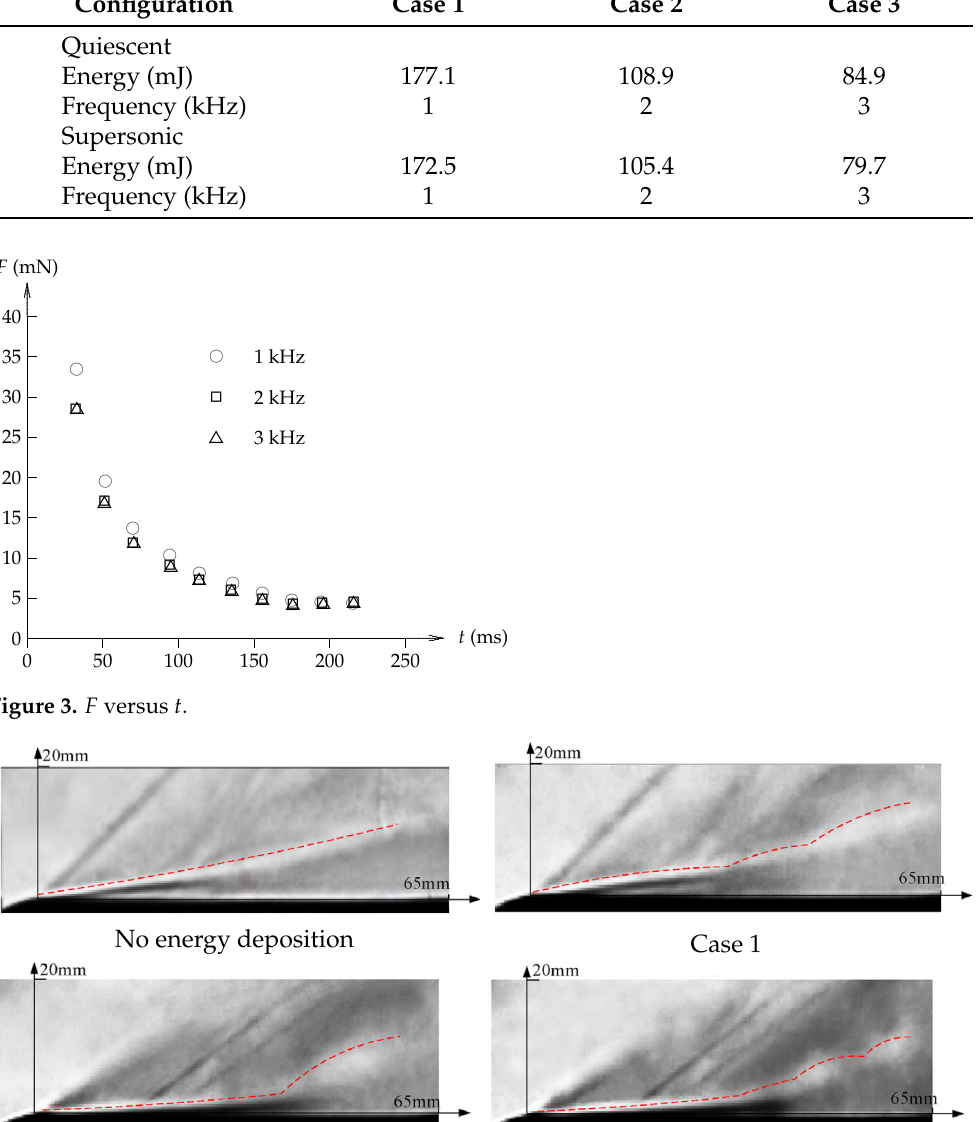
Table 3. SparkJet Parameters.